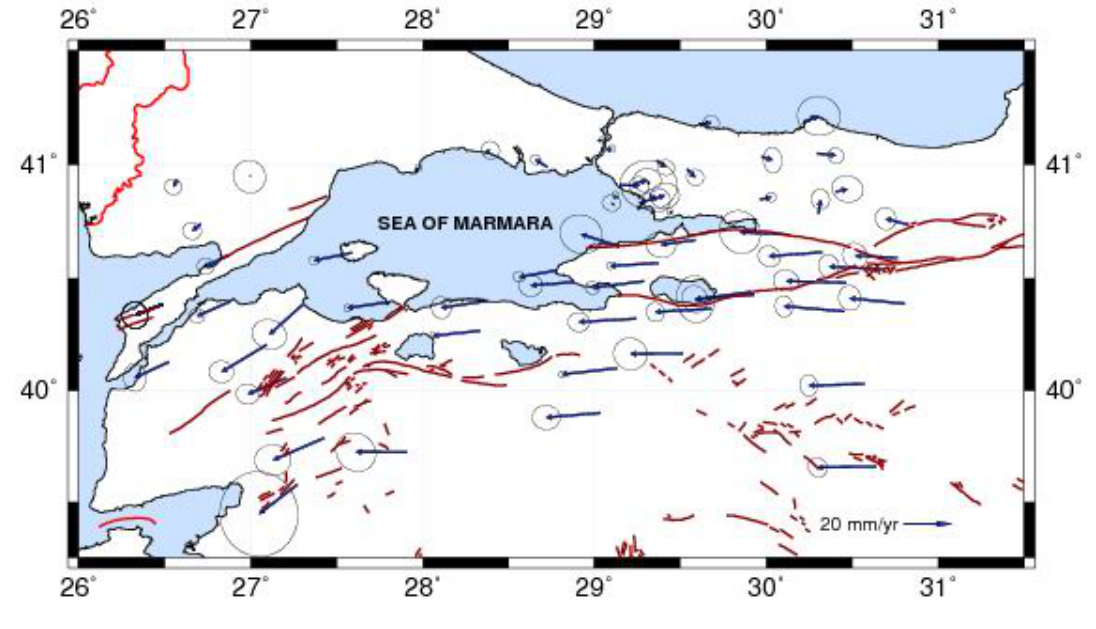
Figure 5. Horizontal velocity field of the Marmara Region in a Eurasia-fixed reference frame (ellipses are at 95% confidence level and the data covers 2003–2005 time